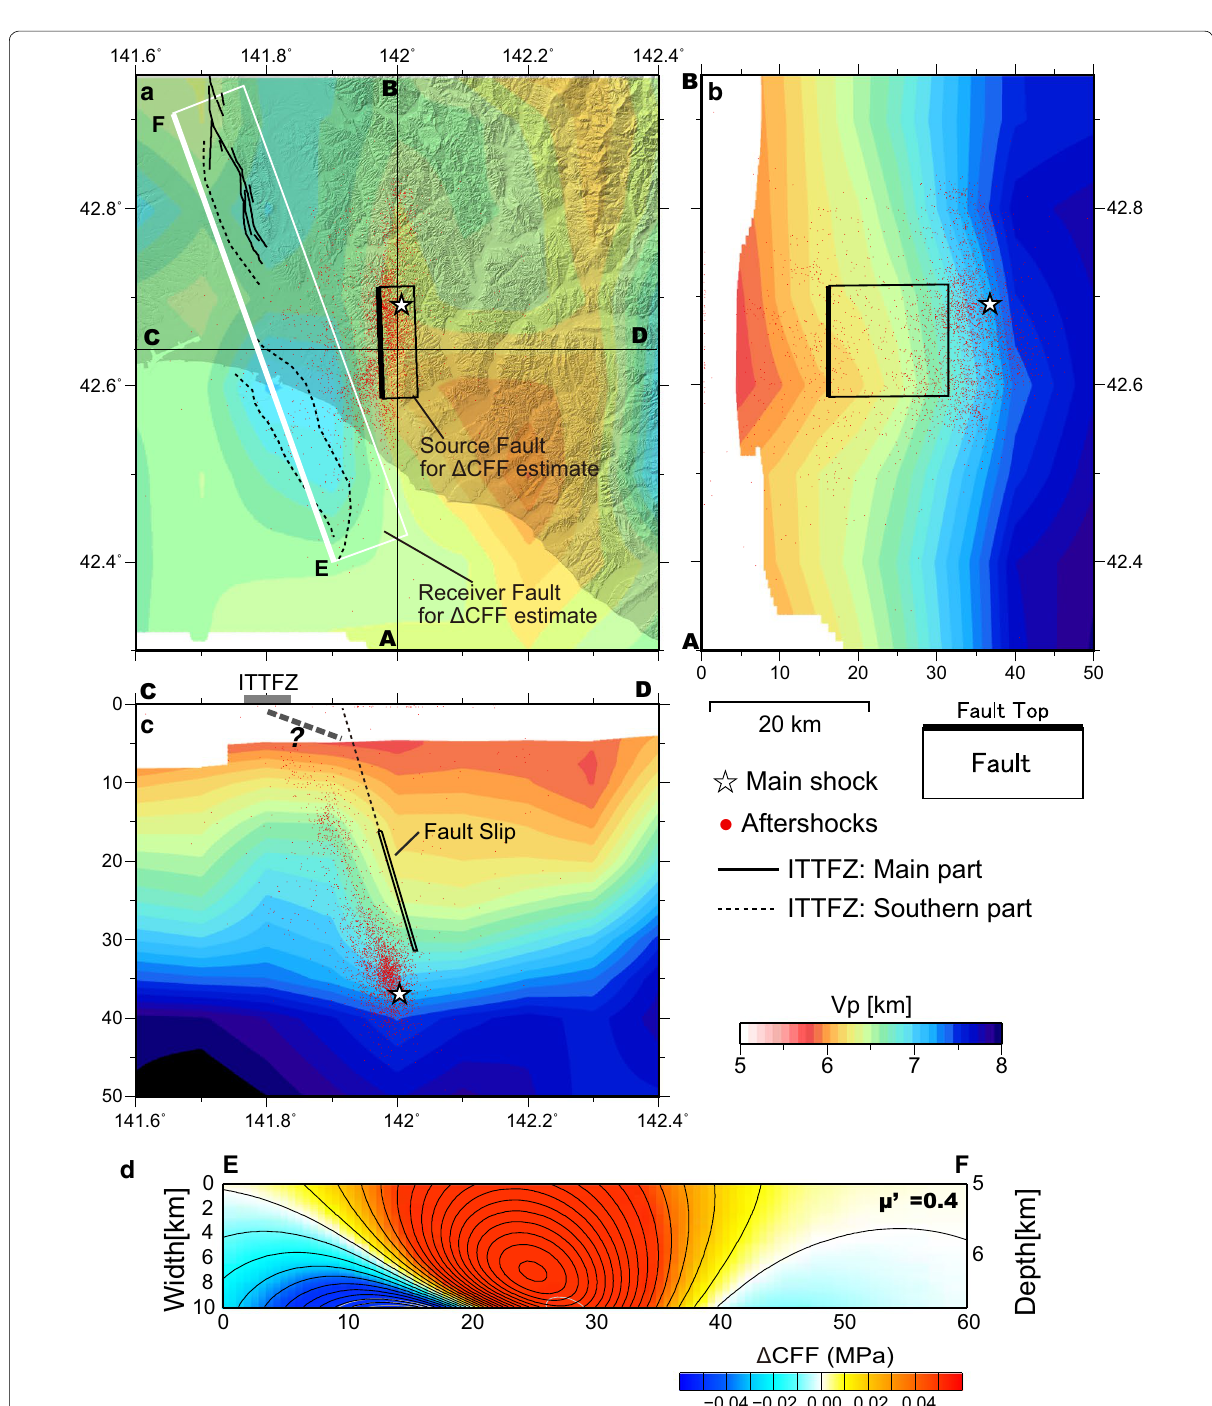
Fig. 3 a Horizontal profile of Vp. Black frame represents an estimated fault plane, projected on the profile. Warm and cool colors indicate low and high Vp, respectively. b Vertical profile in the latitudinal direction. c Vertical profile in the longitudinal direction. d ΔCFF distributions on a low-dip-angle fault equivalent to the ITTFZ. The location of the receiver fault is indicated by a white frame in ( a ). The contour interval is 0.01